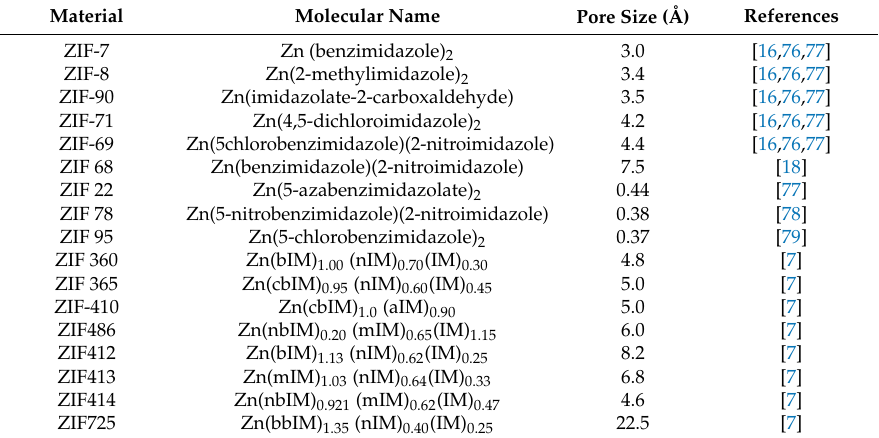
List of abbreviations used in the above table. bIM- benzimidazole; nIM -nitroimidazole; IM- Imidazole; cbIM- 5-chlorobenzimidazole; aIM- Imidazole-2-carboxaldehyde; nbIM-6-nitrobenzimidazole; mIM -2-methylimidazole; bbIM -